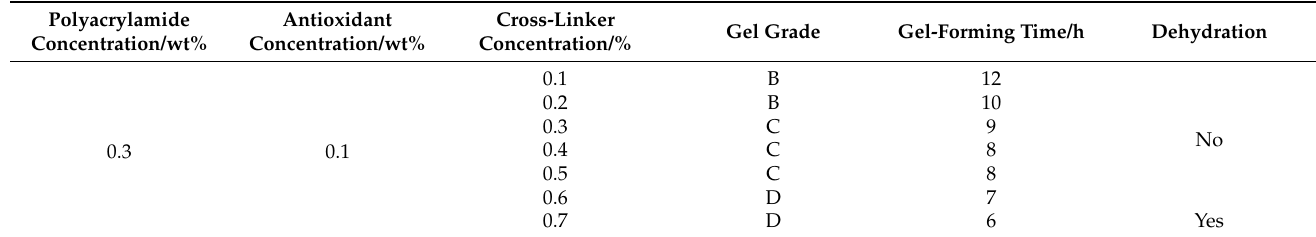
Table 2. The experimental settings and results of the cross-linking reactions. Polyacrylamide Antioxidant Cross-Linker Gel Grade Gel-Forming Time/h Concentration/wt% Concentration/wt% Concentration/%